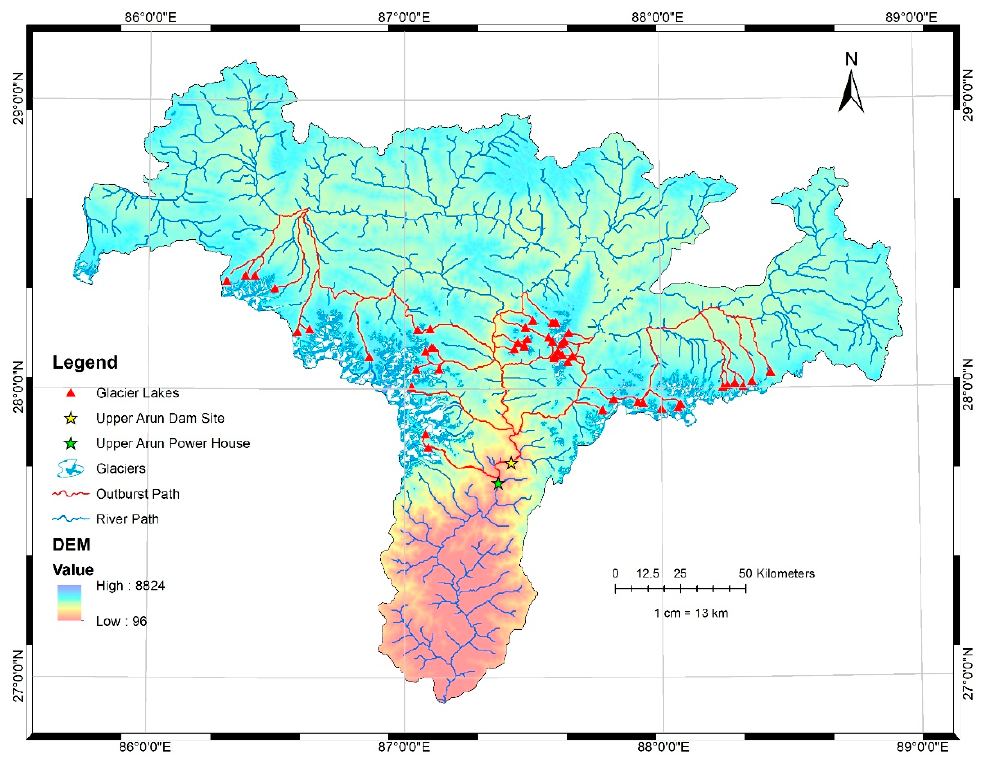
Figure A2. Simulated outburst paths.